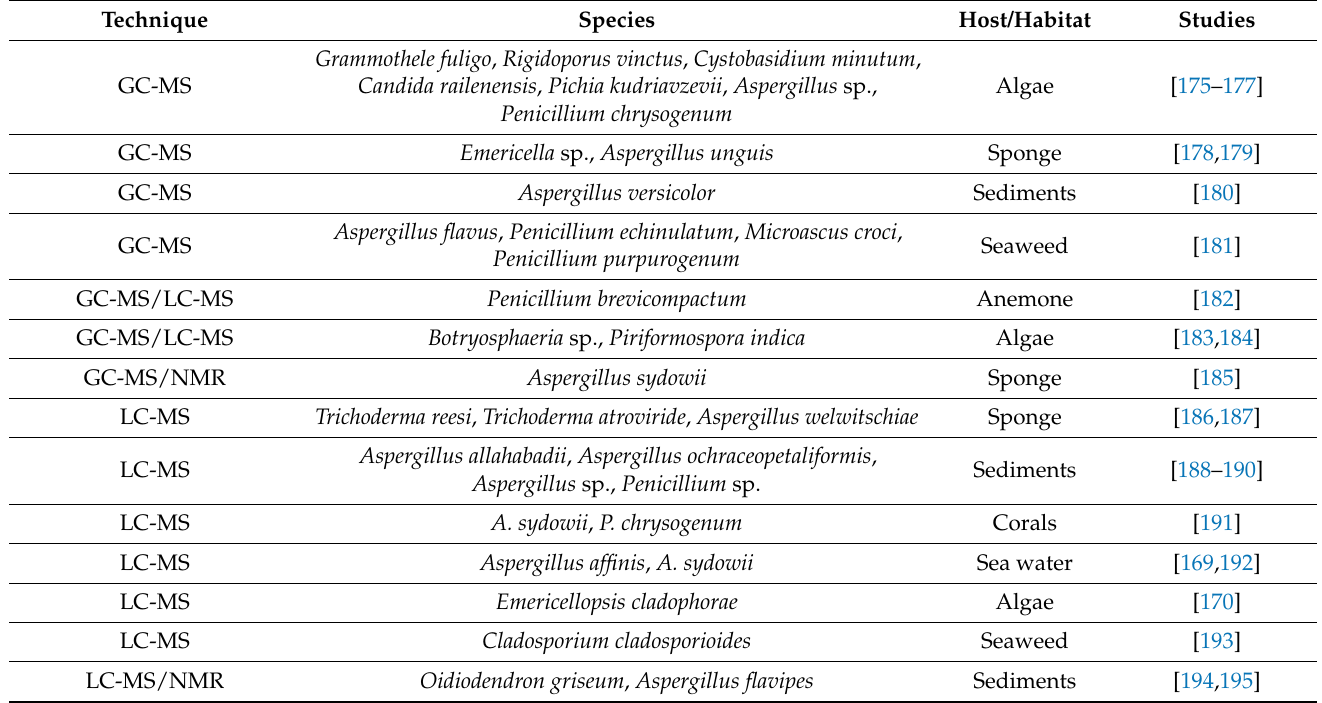
Table 2. Different MS techniques used on marine fungi